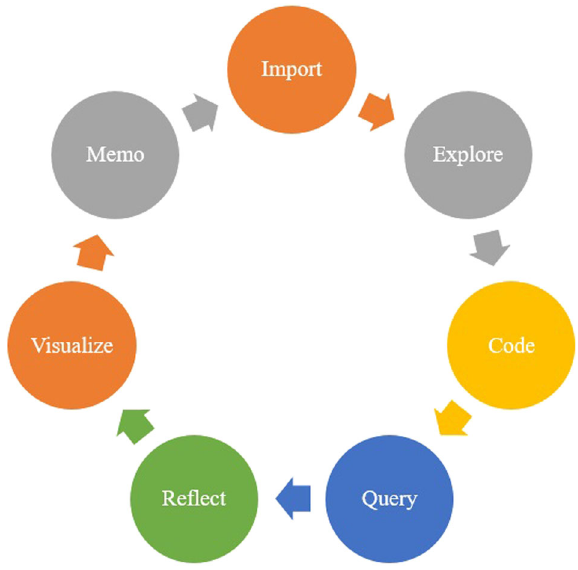
Fig. 1 NVIVO data analysis